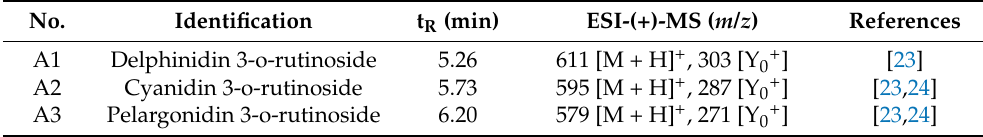
Table 1. Anthocyanin components in petals of ‘QN’.